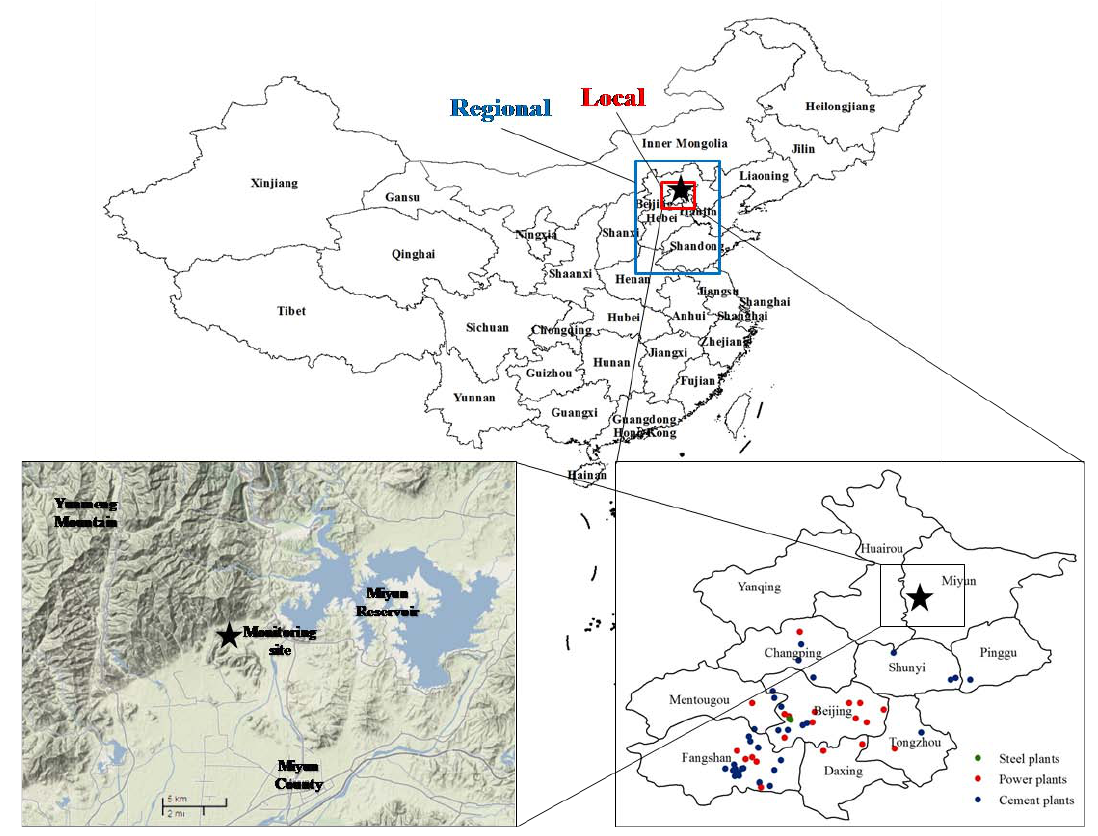
Fig. 1. The location of the Miyun monitoring station in Beijing,